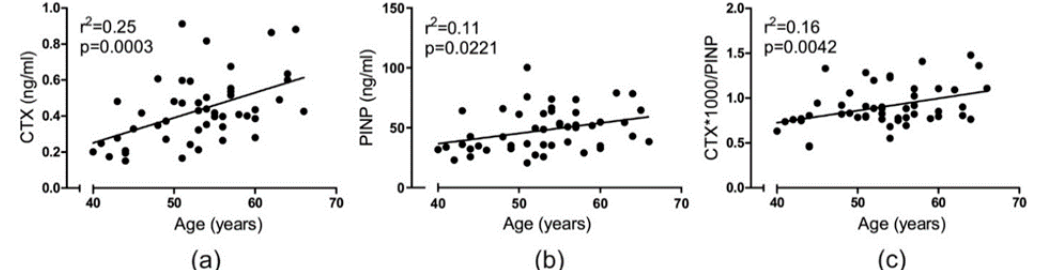
Figure 1. Bone resorption (CTX) and formation (PINP) increase with age. The relation between donor age and ( a ) the level of CTX (ng/mL) in vivo, ( b ) PINP (ng/mL) in vivo, and ( c ) the ratio between CTX and PINP in vivo. Statistics: correlation analyses were performed using Pearson’s correlation (r 2 ). Each point represents the values for an individual donor ( n = 49).